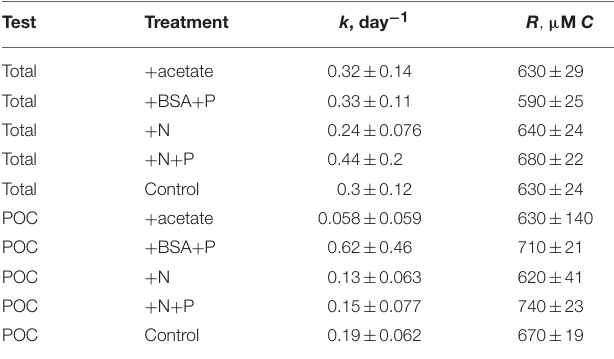
TABLE 1 | Modeled rate constants ( k ) and modeled recalcitrant organic carbon concentration ( R ) for total O 14 C and PO 14 C in each incubation. Test Treatment